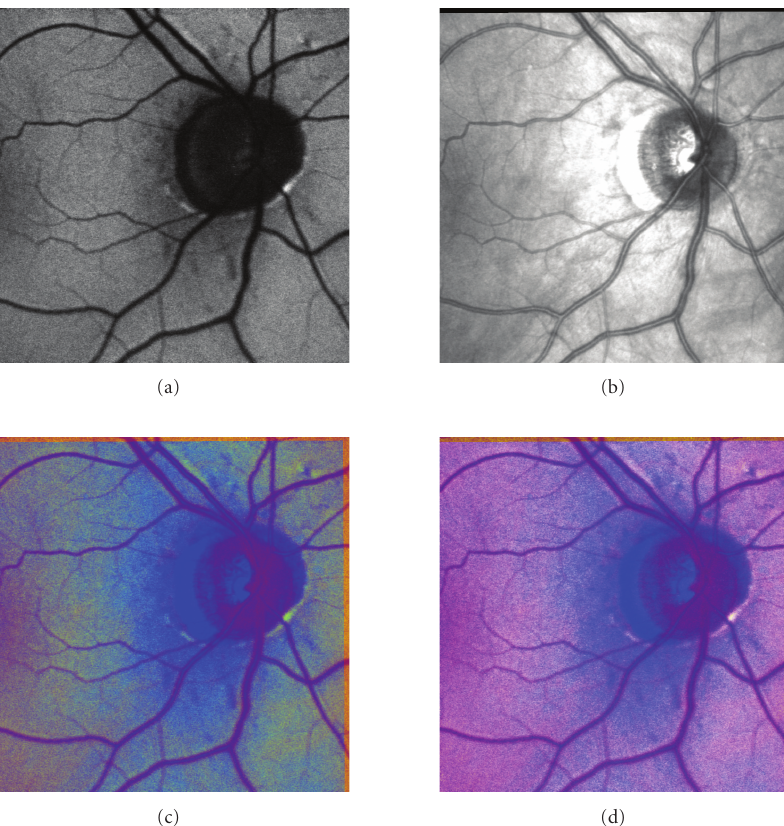
Figure 10: Another example of AF-IR fusion results: (a) AF image, (b) IR image, (c) HVS method, (d) TV-IR